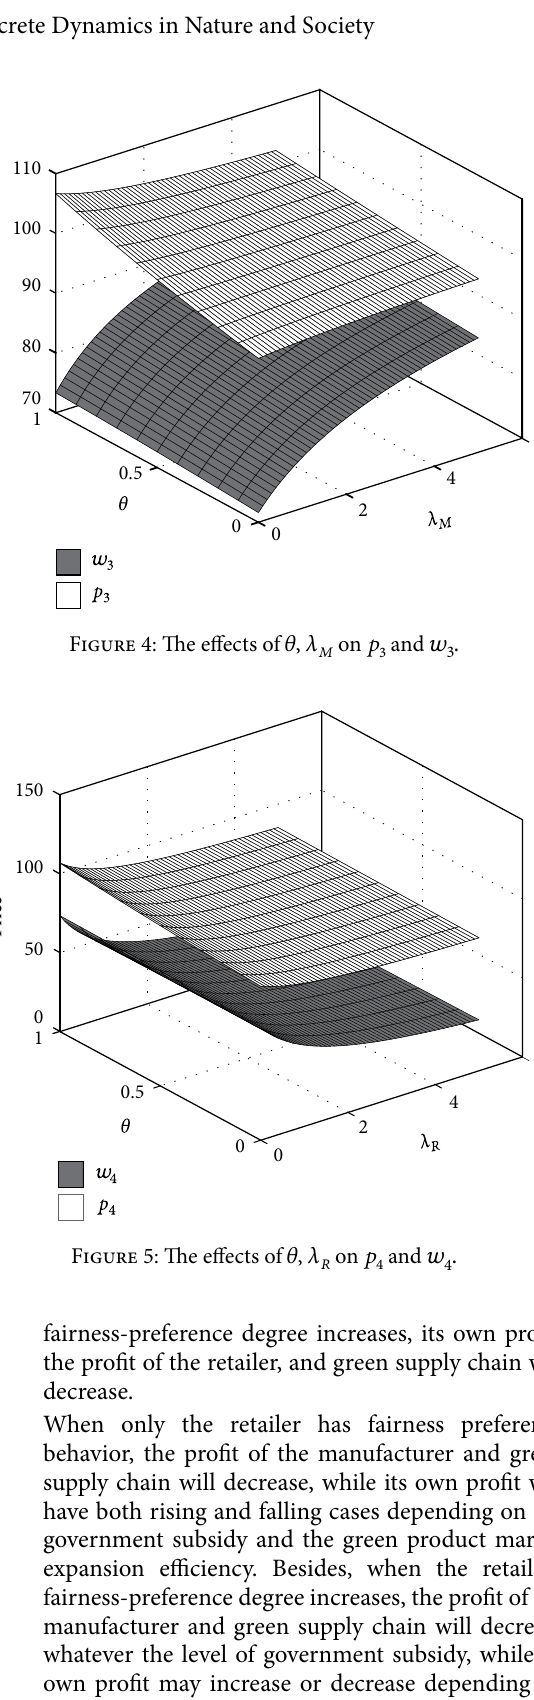
Figure 7: The effect of 𝜃 , 𝜆